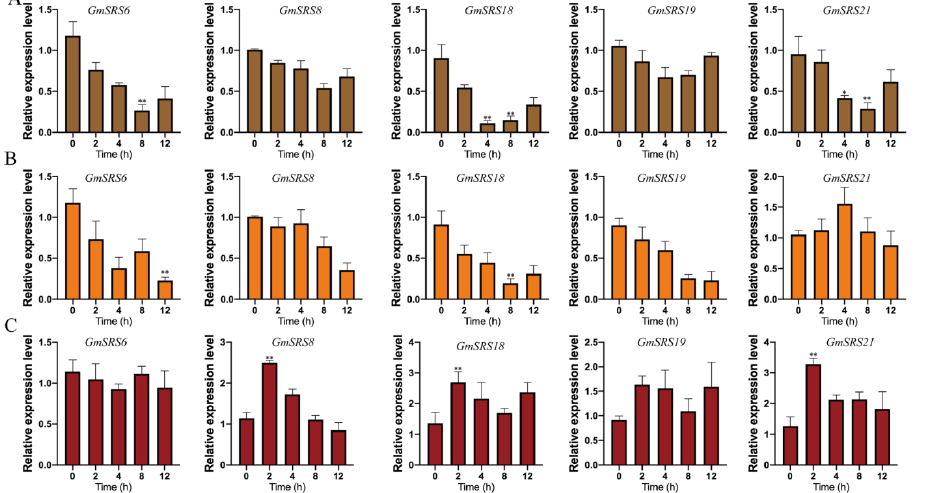
Figure 6. Relative expression levels of soybean SRS genes under drought, NaCl, and exogenous ABA treatment. quantitative Real-Time PCR (qRT-PCR) analyses of plants treated with drought ( A ), NaCl ( B ), and ABA ( C ). * p < 0.05, ** p < 0.01.